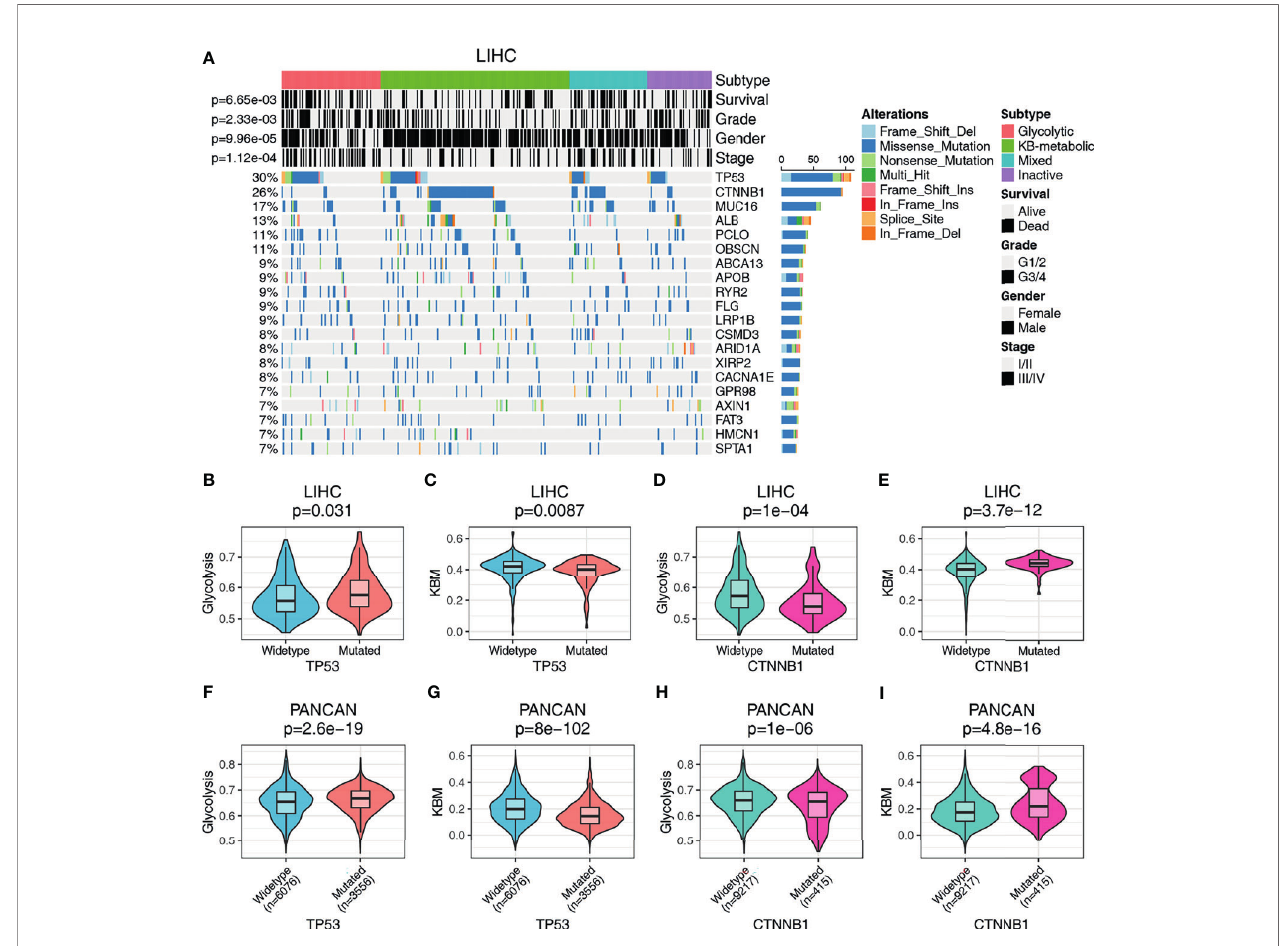
FIGURE 4 | The genomic landscape of metabolic subgroups and mutational characteristics. (A) Oncoplot summarizing the distribution of SNVs and INDELs mutational frequency in LIHC across the metabolic subtypes for the top 20 most mutated genes. Top panel details gender, tumor grade, stage, and prognosis for HCC patients. The metabolic activity of glycolysis or KBM in TP53 or CTNNB1 wildtype or mutation patients in LIHC (B – E) or PANCAN dataset (F – I) . Student ’ s t-test or Wilcoxon rank-sum test were used to compare the median values of two sets of continuous variables. The count data were analyzed with Pearson